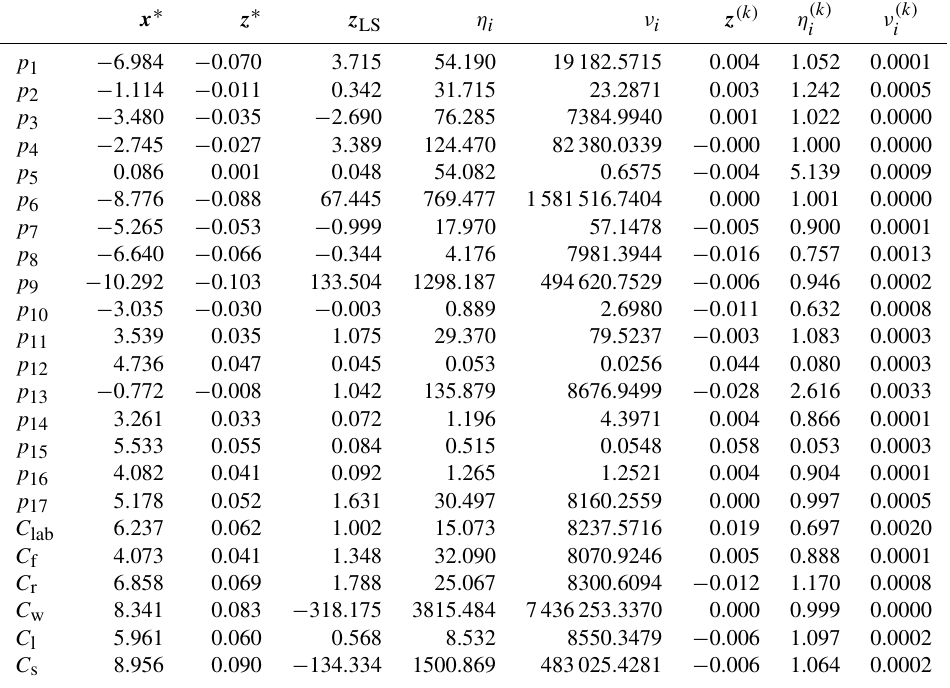
Table 2. Results of the linear inverse problem showing (1) the solution components for the least squares solution z LS together with their relative error η i (dimensionless quantity) and variance ν i and (2) the solution components for the TSVD solution z (k) together with their relative error η (k) and variance ν (k) i i